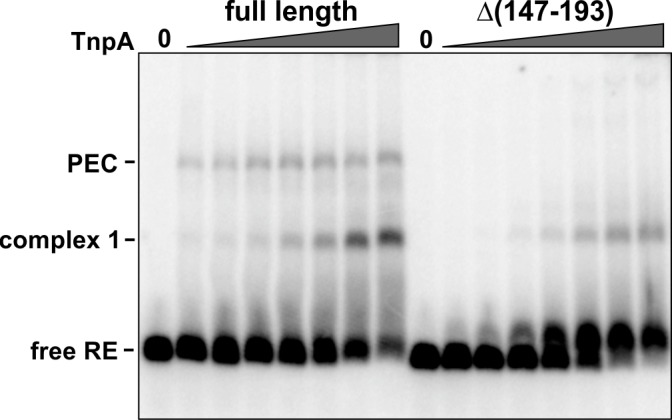
Formation of IS1535 RE complex 1 with TnpAΔ(helix E).Binding of 1 to 64 nM full-length TnpA and Δ(147-193) to the IS1535 RE. TnpAΔ(147-193) forms complex 1, but not PECs, with the RE.